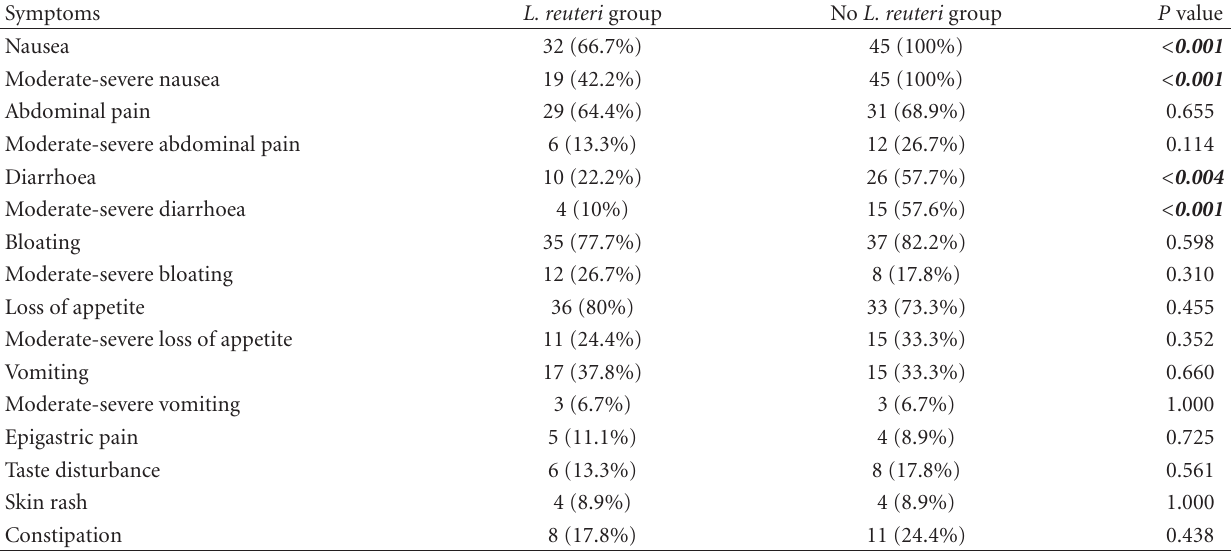
Table 3: HP-eradication: univariate analysis of symptom